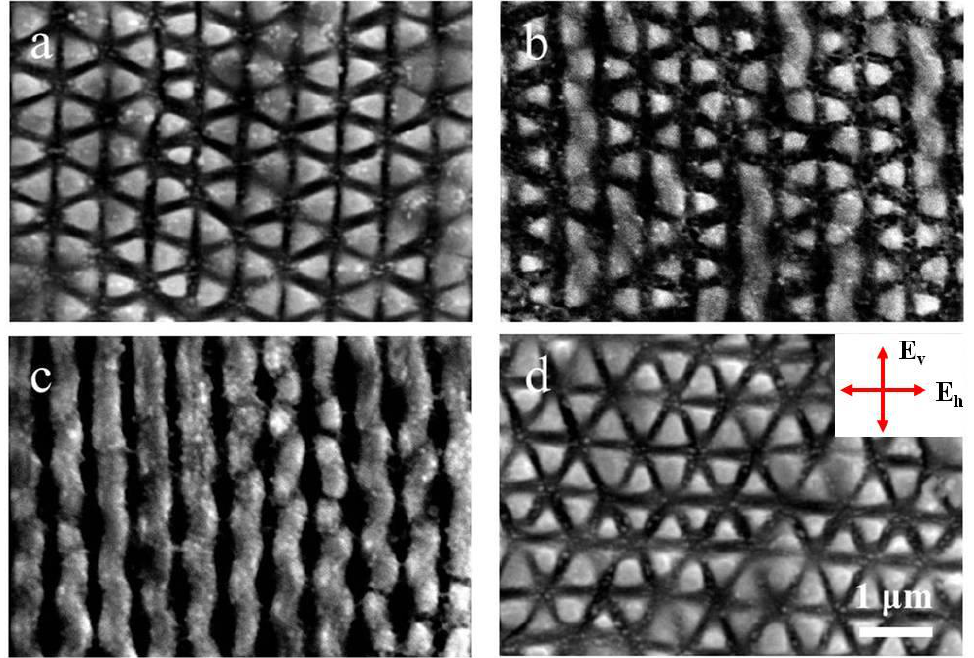
Figure 5. Morphological changes of the tungsten surface irradiated by double-pulsed femtosecond lasers at variable time delays. ( a ) ∆t = −5 ps, ( b ) ∆t = −40 ps, ( c ) ∆t = −80 ps, and ( d ) ∆t = 5 ps. The energies of the two femtosecond lasers are E h = 0.082 mJ and E v = 0.068 mJ, respectively. Their linear polarization directions are denoted by the red double arrows.